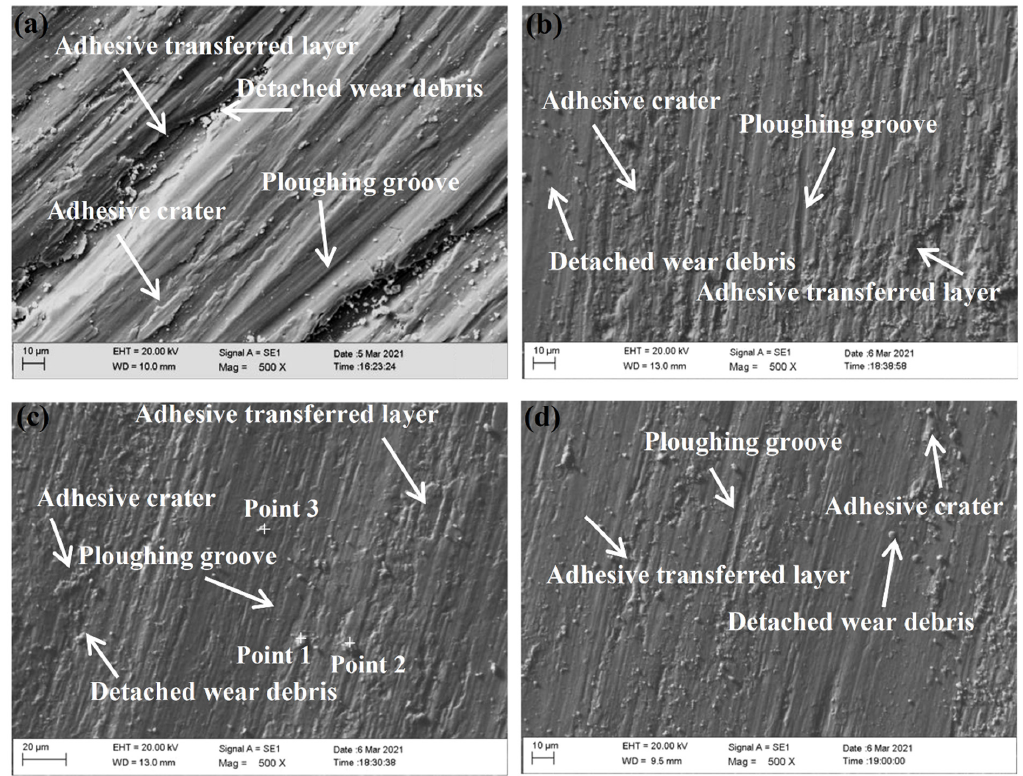
Figure 11. Wear surface morphologies of the substrate and coatings with different laser scanning speeds: ( a ) Ti-6Al-4V substrate, ( b ) 12 mm/s, ( c ) 15 mm/s and ( d ) 18 mm/s.